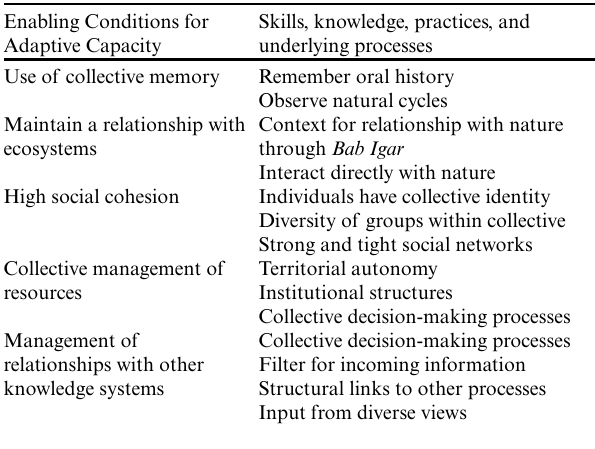
Table 1 . Skills, knowledge, practices, and underlying processes that build enabling conditions for Guna adaptive